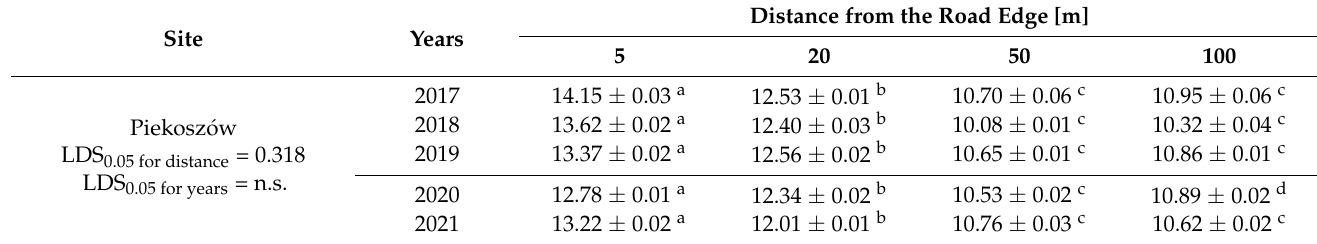
Table 11. Urease activity (AU in mg N-NH 4+ kg − 1 h − 1 ) in soils before the COVID-19